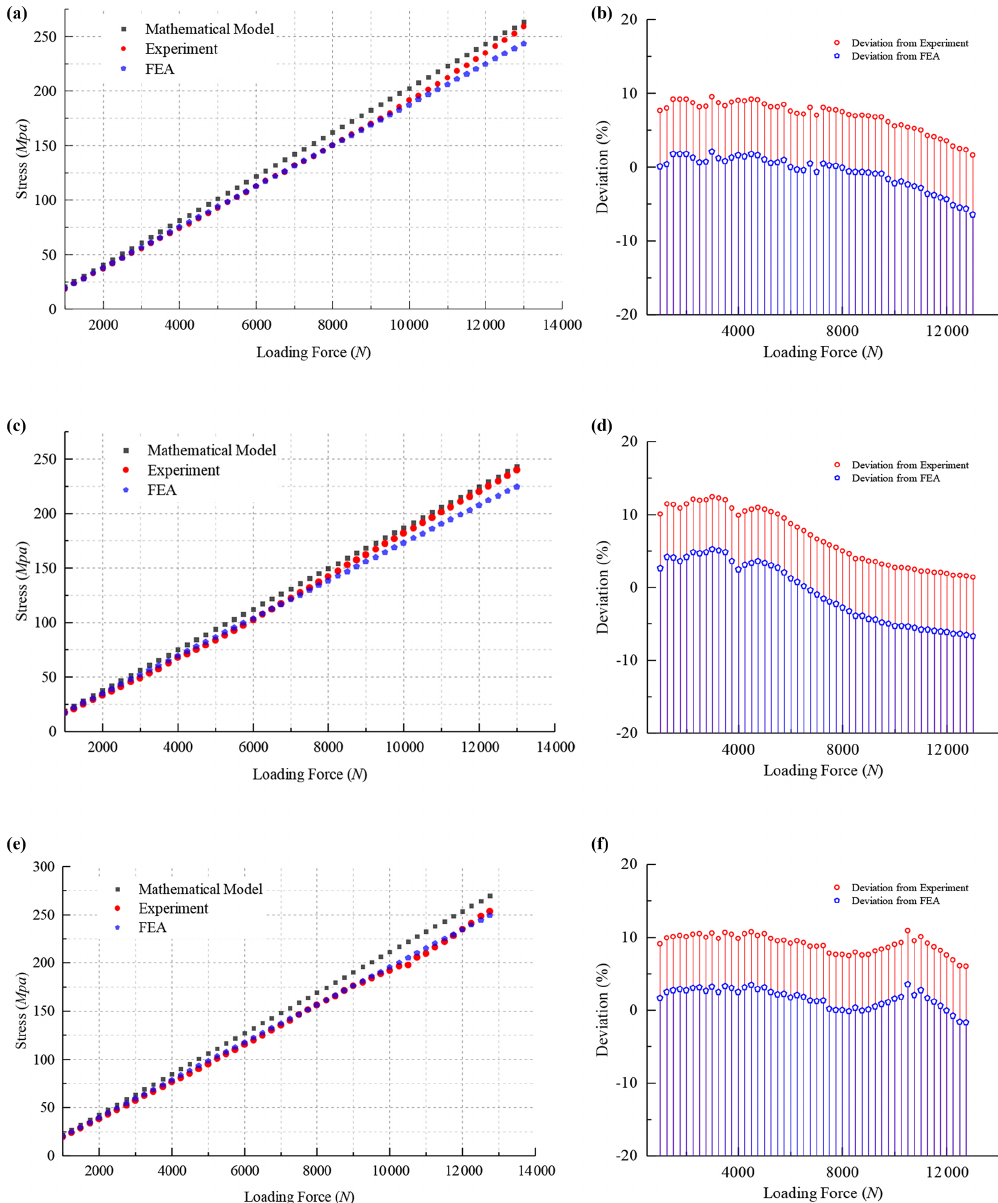
Figure 13. The experimental data of ratchet 2. The comparison between the experiment and mathematical model and its deviation for (a, b) tooth 1, (c, d) tooth 2 and (e, f) tooth